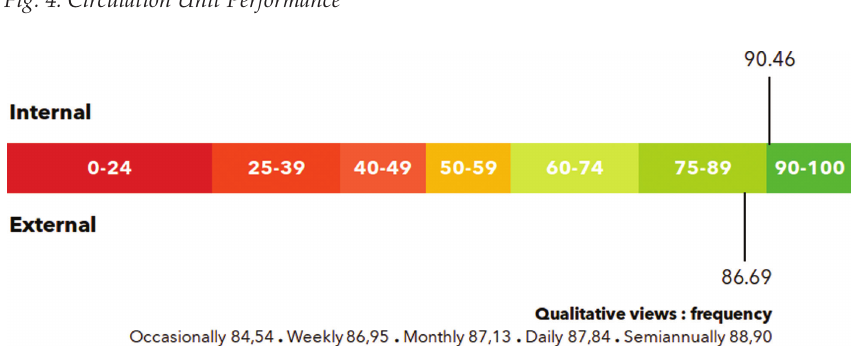
Fig. 4: Circulation Unit